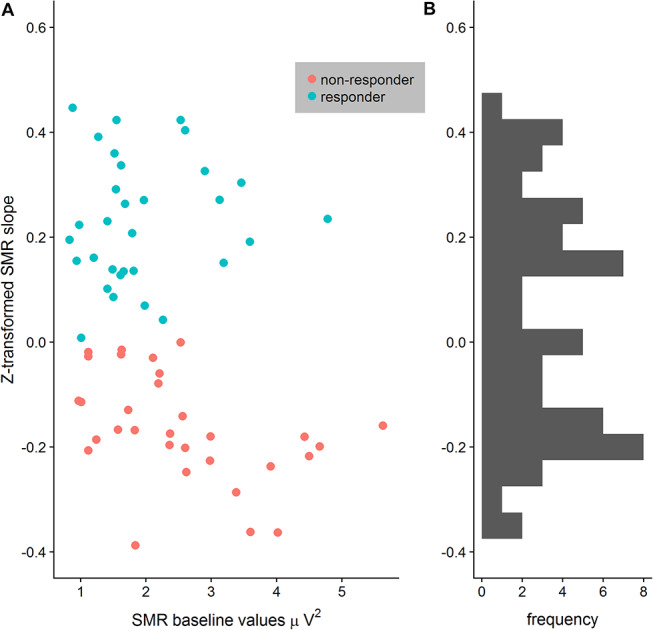
(A) Distribution of z-transformed SMR slopes depicted in function of SMR baseline values separately for responders and non-responders. The separation between responders and non-responders is particular clear when SMR baseline values increase. (B) Histogram of the z-transformed SMR slopes reveals no central tendency but rather a bimodal distribution.